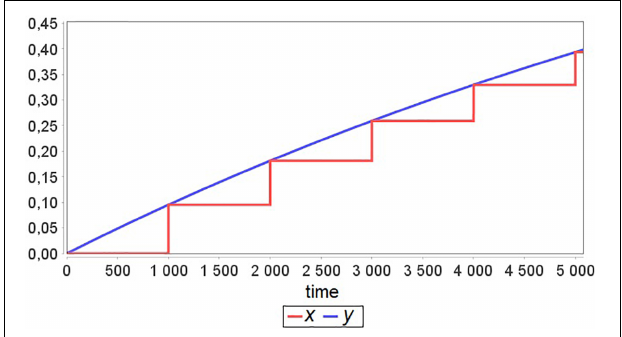
FIGURE 2 | A simulation example for the model defined in Figure 1 with T x (cid:29) T y and time (cid:49) = 1000 between agent